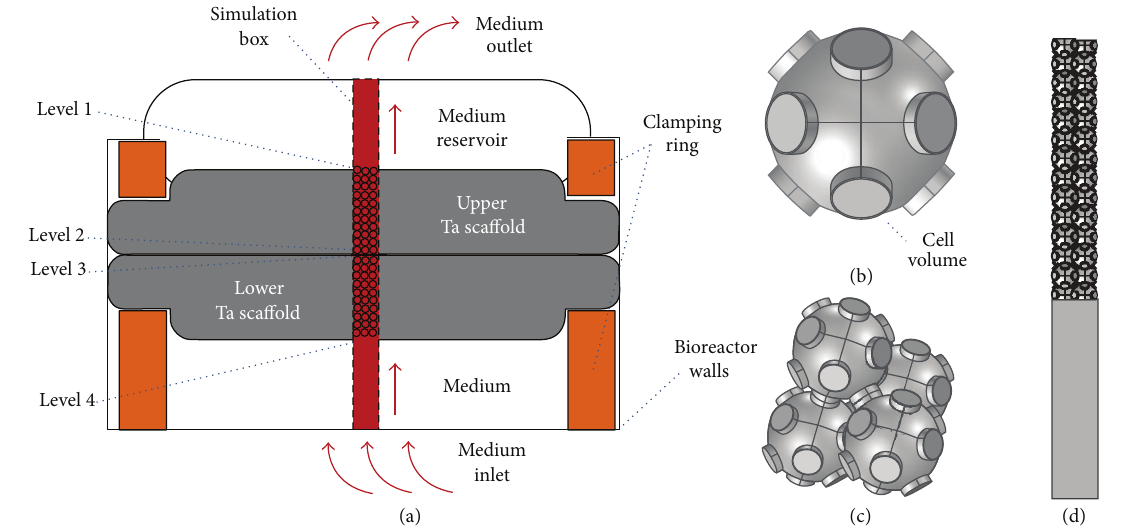
Figure 4: Computer model of the cell population in the 3D channel structure of the Ta scaffold. (a) Cross section of the perfusion reactor with the two cell-populated Ta scaffolds inside. The simulation box is located in the center of the figure. The porous channel structure of the scaffold is modeled by interconnected spherical cavities whose walls are occupied by cells. (b) Double-walled cavity with connections to adjacent cavities. The narrow region between the inner and the outer wall represents the cell-populated area. (c) Construction of the channel structure from many cavities. (d) Lower part of the simulation box consists of the cross section though the Ta disk and the medium reservoir are below the disk. Periodic boundary conditions are assumed (see text for